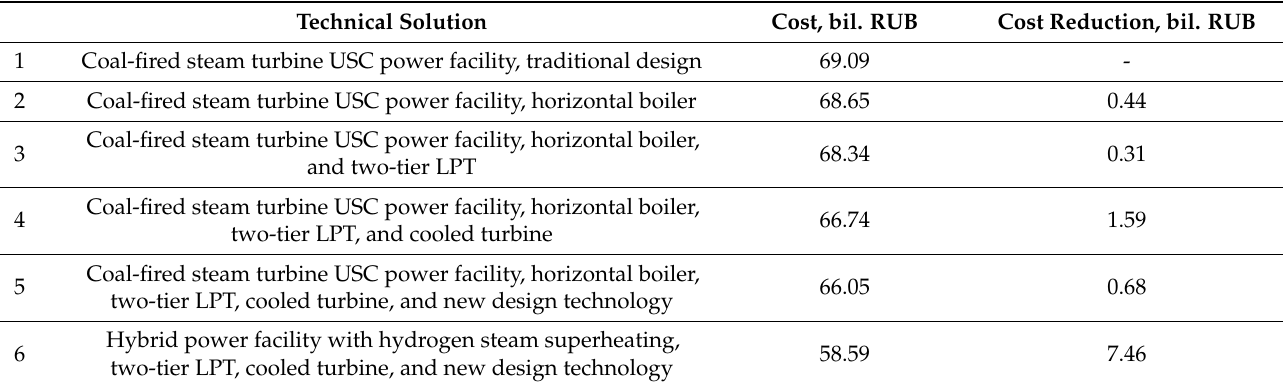
Table 2. Financial effects of the proposed technical solutions’ application.